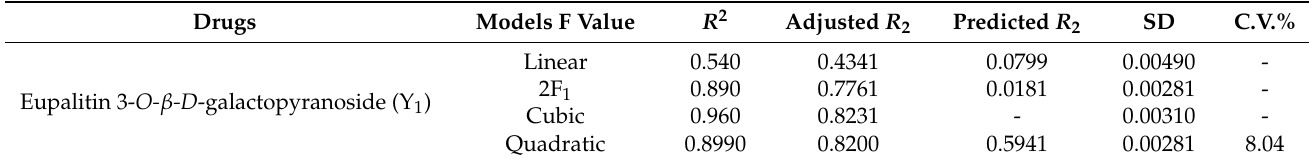
Table 2. Regression analysis results for models and responses (Y 1 ) regression equations for the final suggested